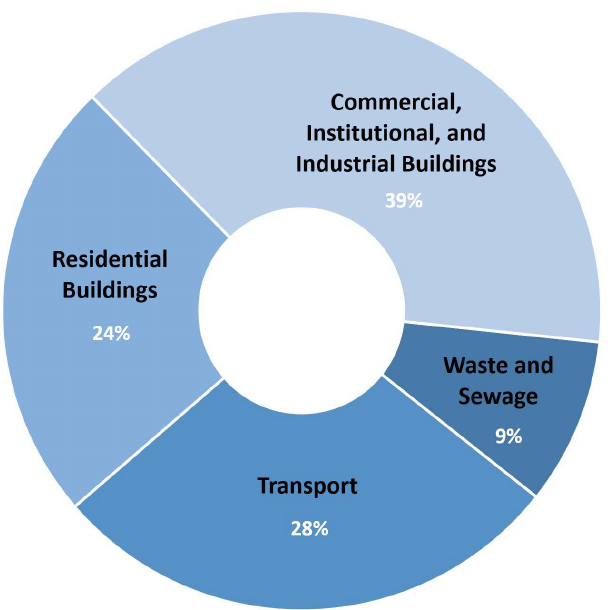
Figure 2. Share of GHG emissions in cities by sector, 2018. Source: German Federal Ministry for Economic Cooperation and Development